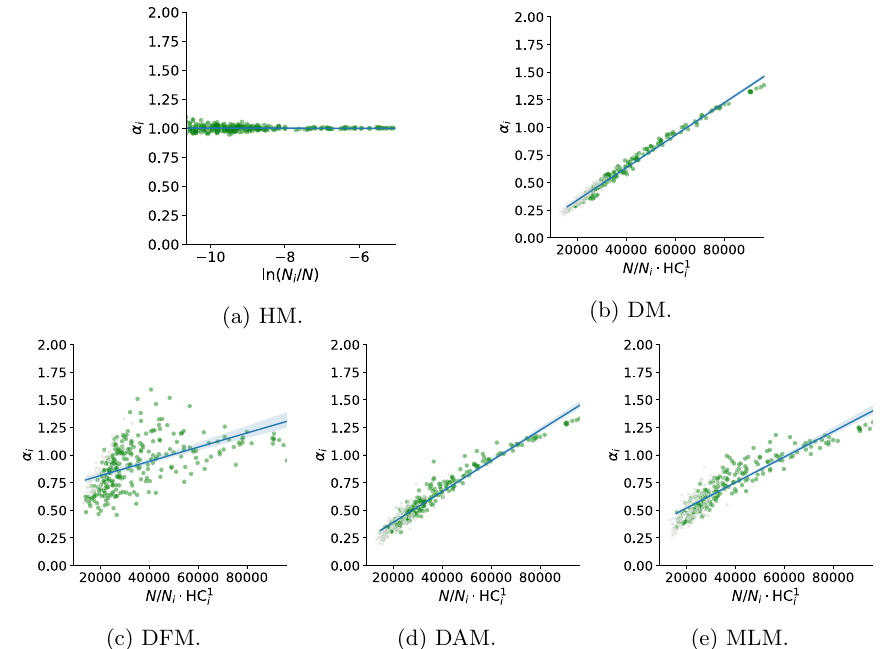
Fig. 2 The dependence of α i upon N i and HC 1 i for the five considered